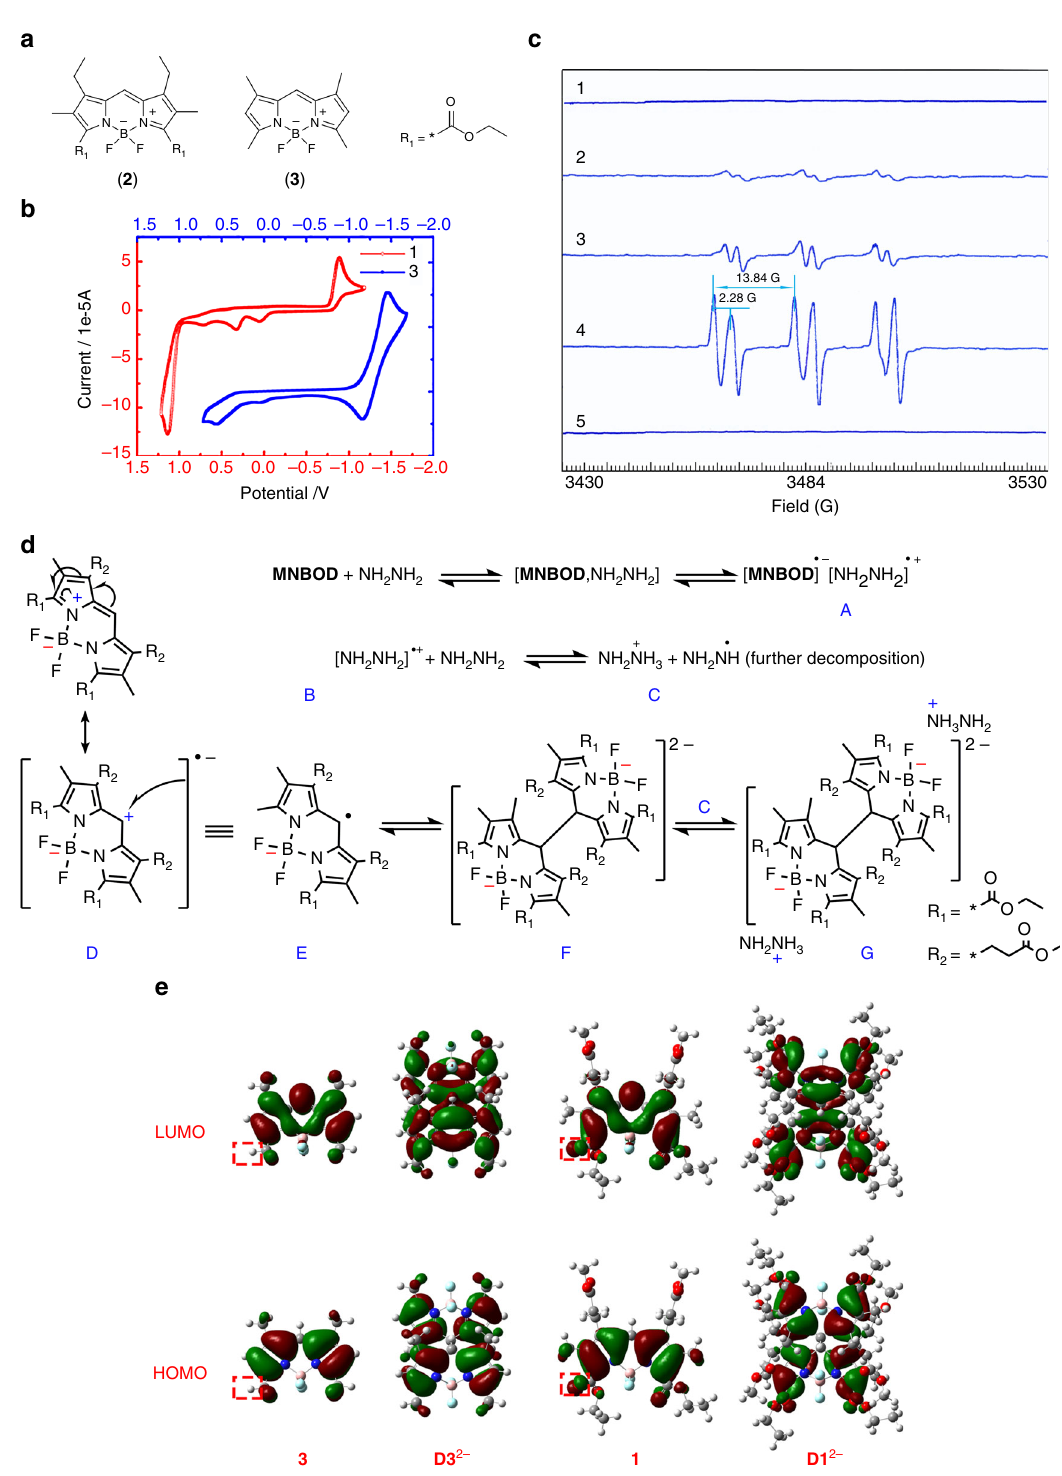
Fig. 4 The molecular mechanisms. a Reference compounds of 2 and 3 . b Cyclic voltammetry (CV) of 1 mM 1 (red) and 1 mM 3 (blue). The mechanism for CV redox and dimerization processes is prosed in Eqs. (1) and (2). c The ESR titrations with hydrazine hydrate. 1 to 4 denote the concentration change of base (hydrazine hydrate) added. 1, the initial state; 5, the colorless state. Field [G]: 3430-3530, Center Field 3484.00, Sweep width 100.0[G]; g = 2.00826; Spin Trap PBN. d The mechanism for hydrazine catalyzed dimerization process. MNBOD is reduced to a radical-anion (D/E) by hydrazine through the intermolecular electron transfer process. The radical-anions E are readily combine into the dianion F while the hydrazine cation (B) can be further reduced in to hydrazine cation (C). The dimer (F) and (C) combine into the fi nal complex (G). e Calculated frontier molecular orbitals of 3 , D3 2 − , 1 and D1 2 − , HOMO and LUMO orbitals are all obtained by DFT